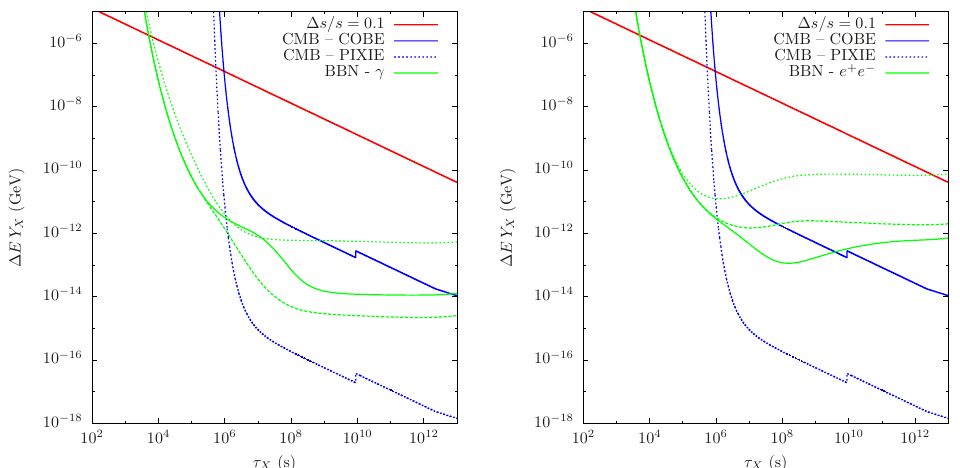
Figure 9 . Other bounds on electromagnetic decays in the early universe as a function of the lifetime (cid:28) X and the total electromagnetic injection (cid:1) E Y X relative to limits derived from BBN. In both panels, the red line shows (cid:1) s=s = 0 : 1, while the solid (dotted) blue lines show the current and projected CMB frequency bounds from COBE/FIRAS (PIXIE). The left panel also indicates the limits derived from BBN for photon injection with energy E X = 10 ; 30 ; 100 MeV with green dotted, dashed, and solid lines. The right panel shows the corresponding BBN bounds from monochromatic e + e (cid:0)